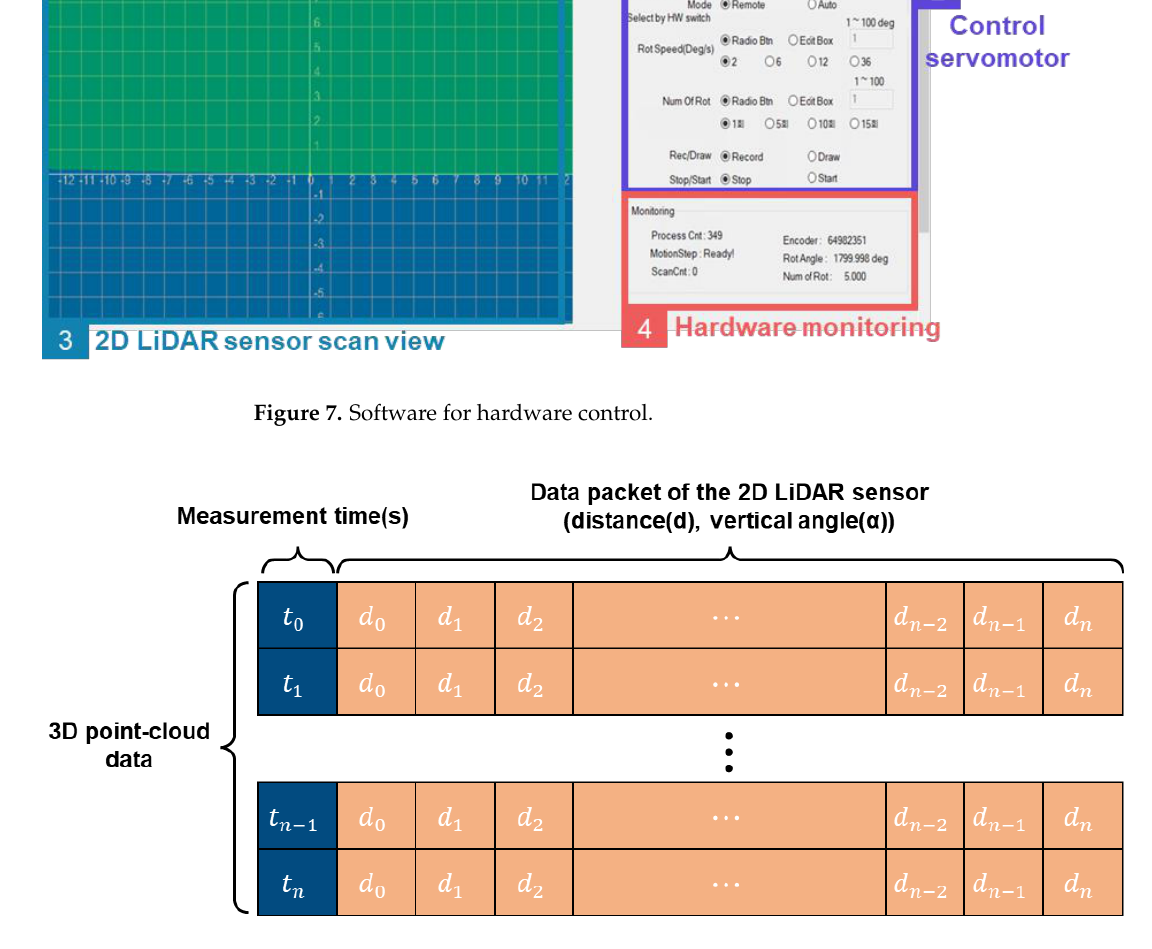
Figure 8. Structure of the 3D point cloud data collected by the hardware.